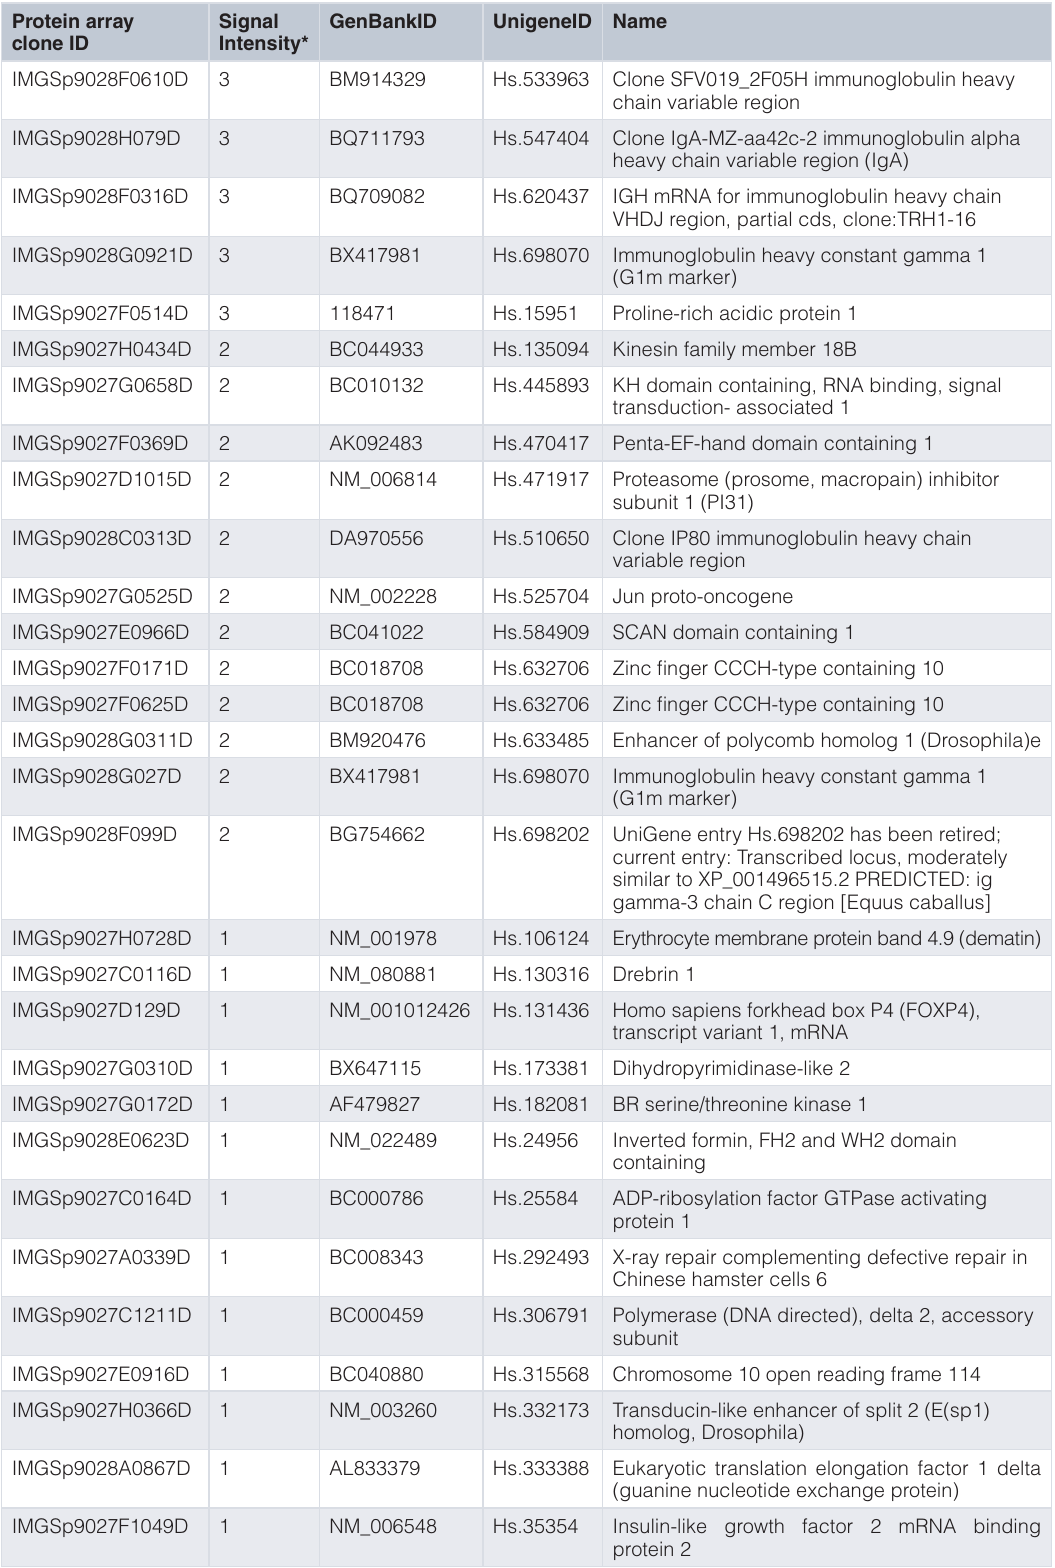
Table 4. Reference list of antibody cross-reactivity identified by protein array analysis. Protein array clone